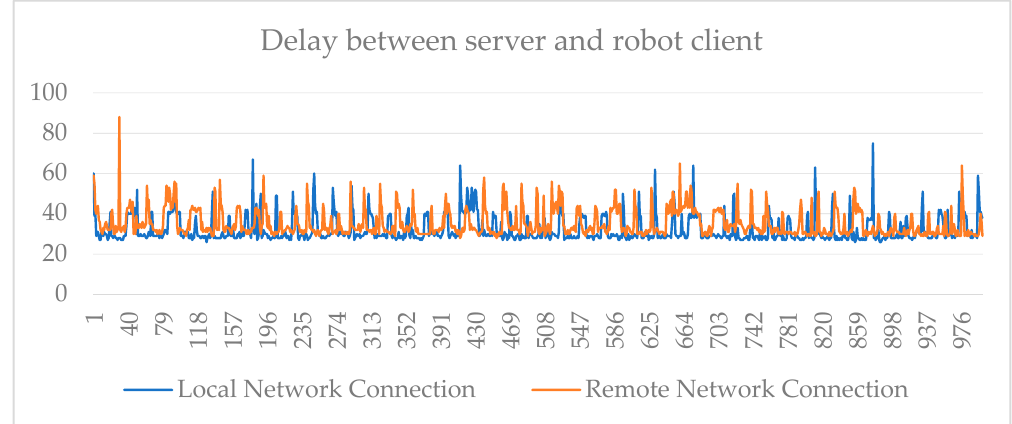
Figure 13. Network delay between robot and server.